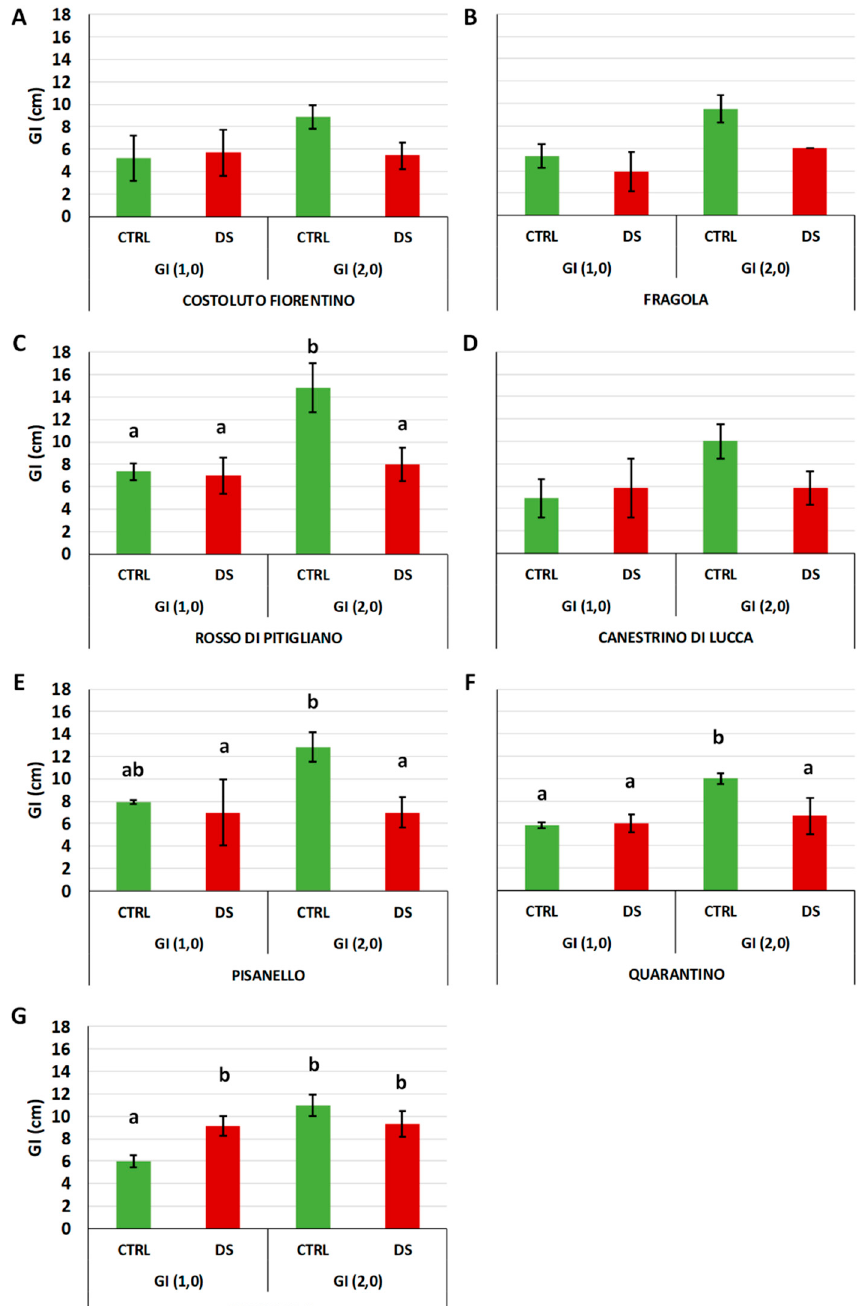
Figure 4. Growth Index (GI) in six local varieties ( A – F ) and one commercial cultivar ‘Supersteak’ ( G ) of tomato ( Solanum lycopersicum L.) subjected to drought stress (no water for 16 days) relative to the controls (regularly well-watered plants). Two-way factorial ANOVA followed by Tukey post-hoc test was used to determine the statistical significance of di ff erences. Points with the same lower-case letters do not di ff er significantly ( p > 0.05). GI ( 1,0 ) = (h 1 − h 0 ) / 2; GI ( 2,0 ) = (h 2 − h 0 ) / 2. While GI is indicative of stress, stem diameter cannot be considered a discriminating parameter.